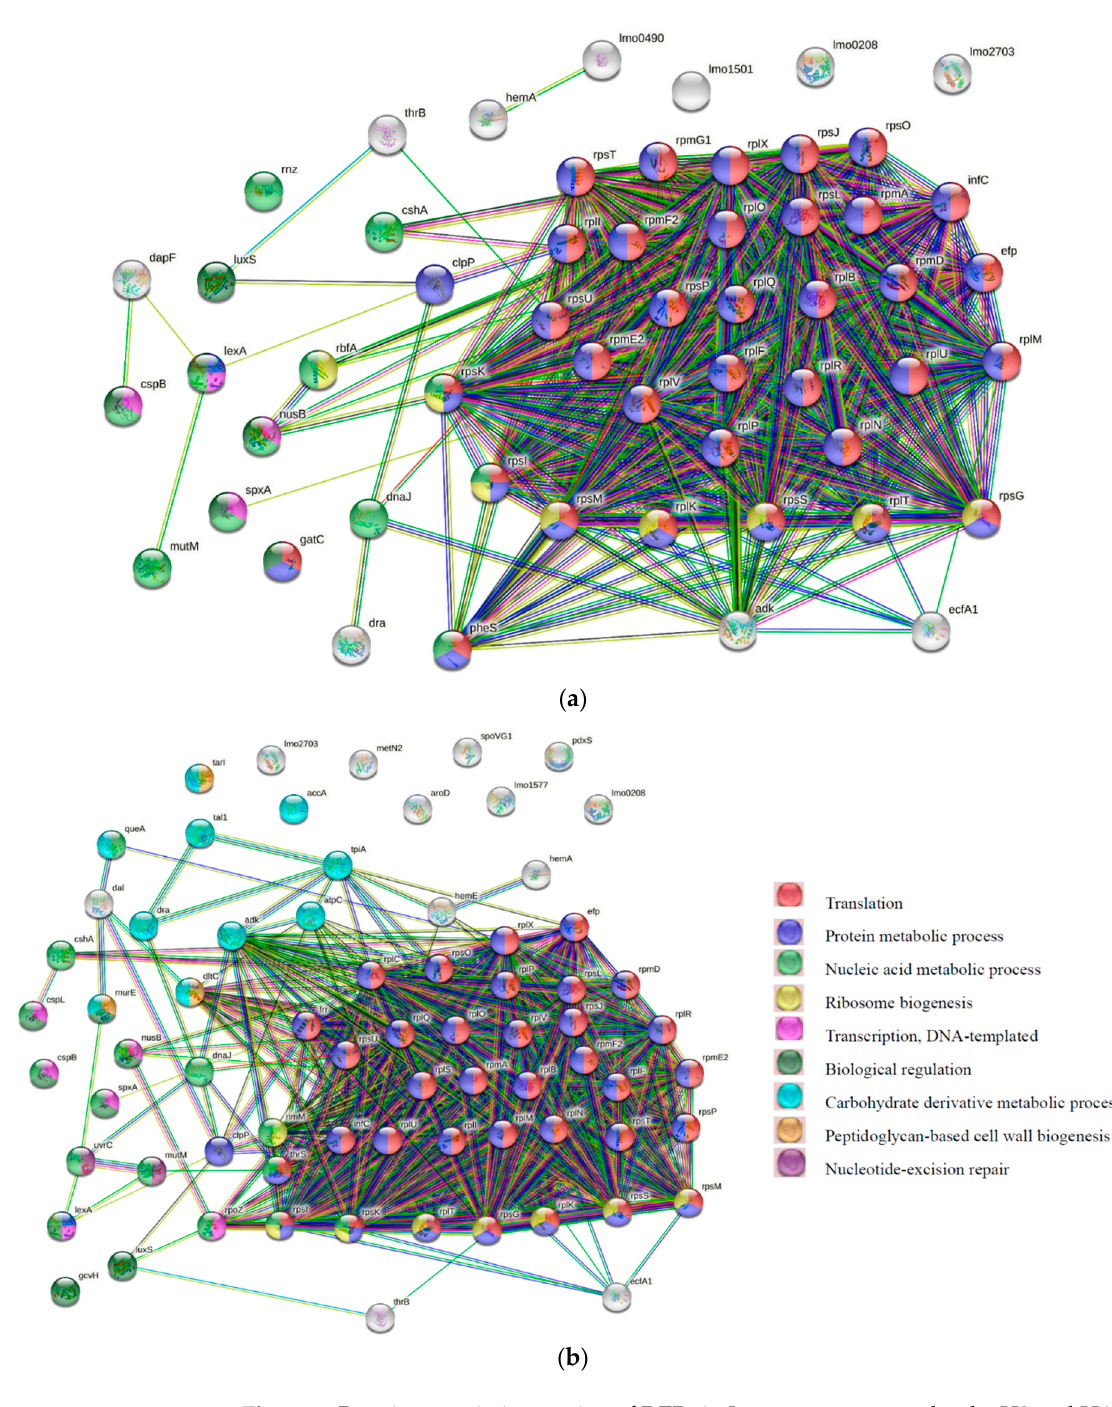
Figure 3. Protein–protein interaction of DEPs in L. monocytogenes under the H2 and H4 treatments. Functional categorization was conducted based on gene ontology (GO) level in STRING Protein– Protein Interaction Networks (v. 11.0) ( a,b ).